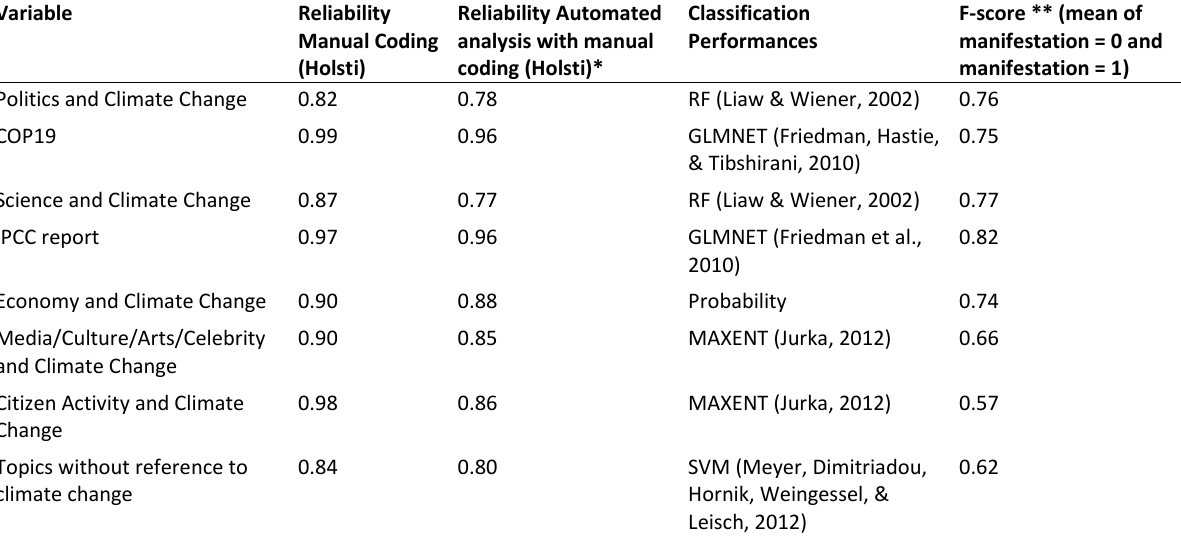
Table 5. Reliability values